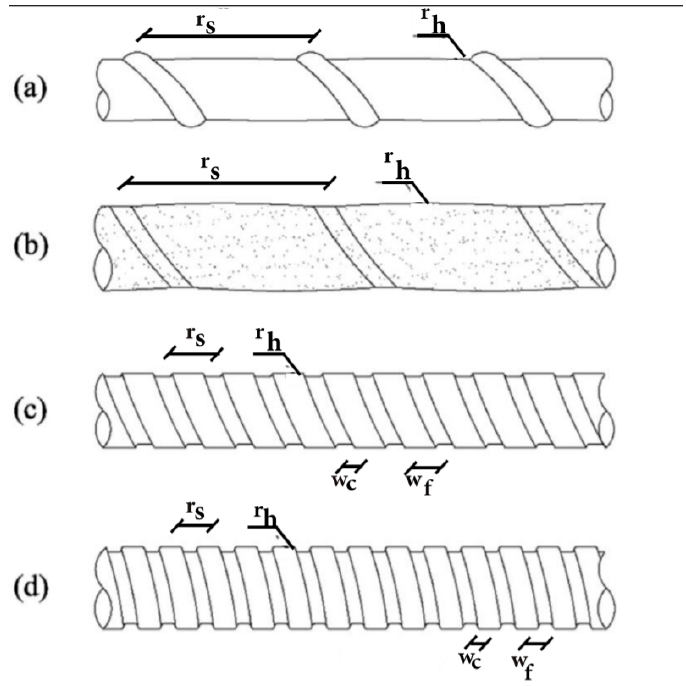
Figure 2. Fiber-reinforced polymers (FRP) bar surface configurations: ( a ) Ribbed and helically wrapped, ( b ) ribbed, helically wrapped, and sand coated, ( c ) indented, ( d ) ribbed.